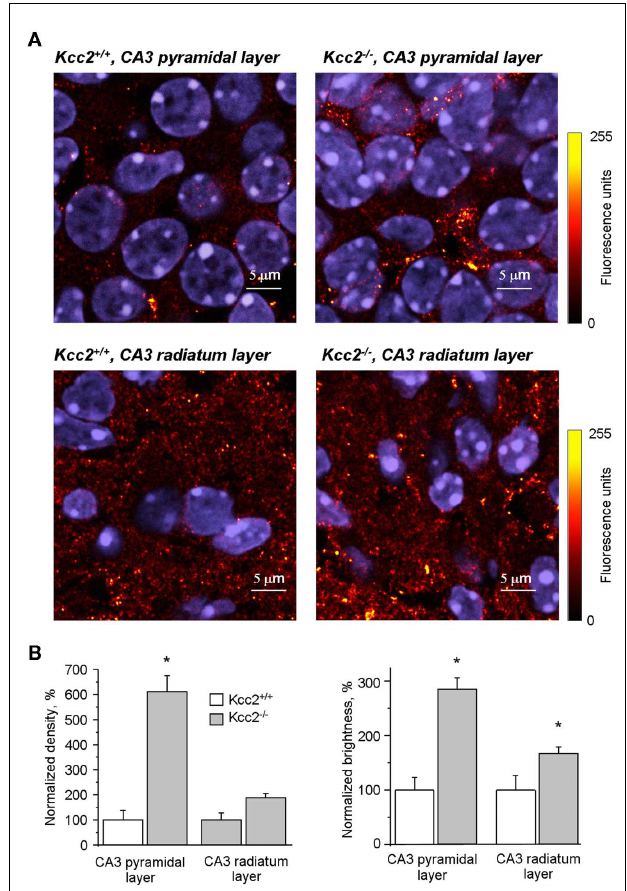
FIGURE 4 | Immunofluorescence of synaptophysin in CA3 hippocampal neurons. (A) Synaptophysin and DAPI fluorescence in CA3 pyramidal and radiatum cell layers of Kcc2 + / + and Kcc2 − / − hippocampi as indicated. Immunofluorescence of synaptophysin was pseudocolored (see scale on the right) for better cluster visualization. Immunofluorescence of DAPI is shown in blue. (B) Normalized density and brightness of synaptophysin positive clusters in CA3 pyramidal layer and CA3 radiatum layer of Kcc2 + / + and Kcc2 − / − hippocampi. Mean ± SEM, n = 3; * = P < 0.05, t